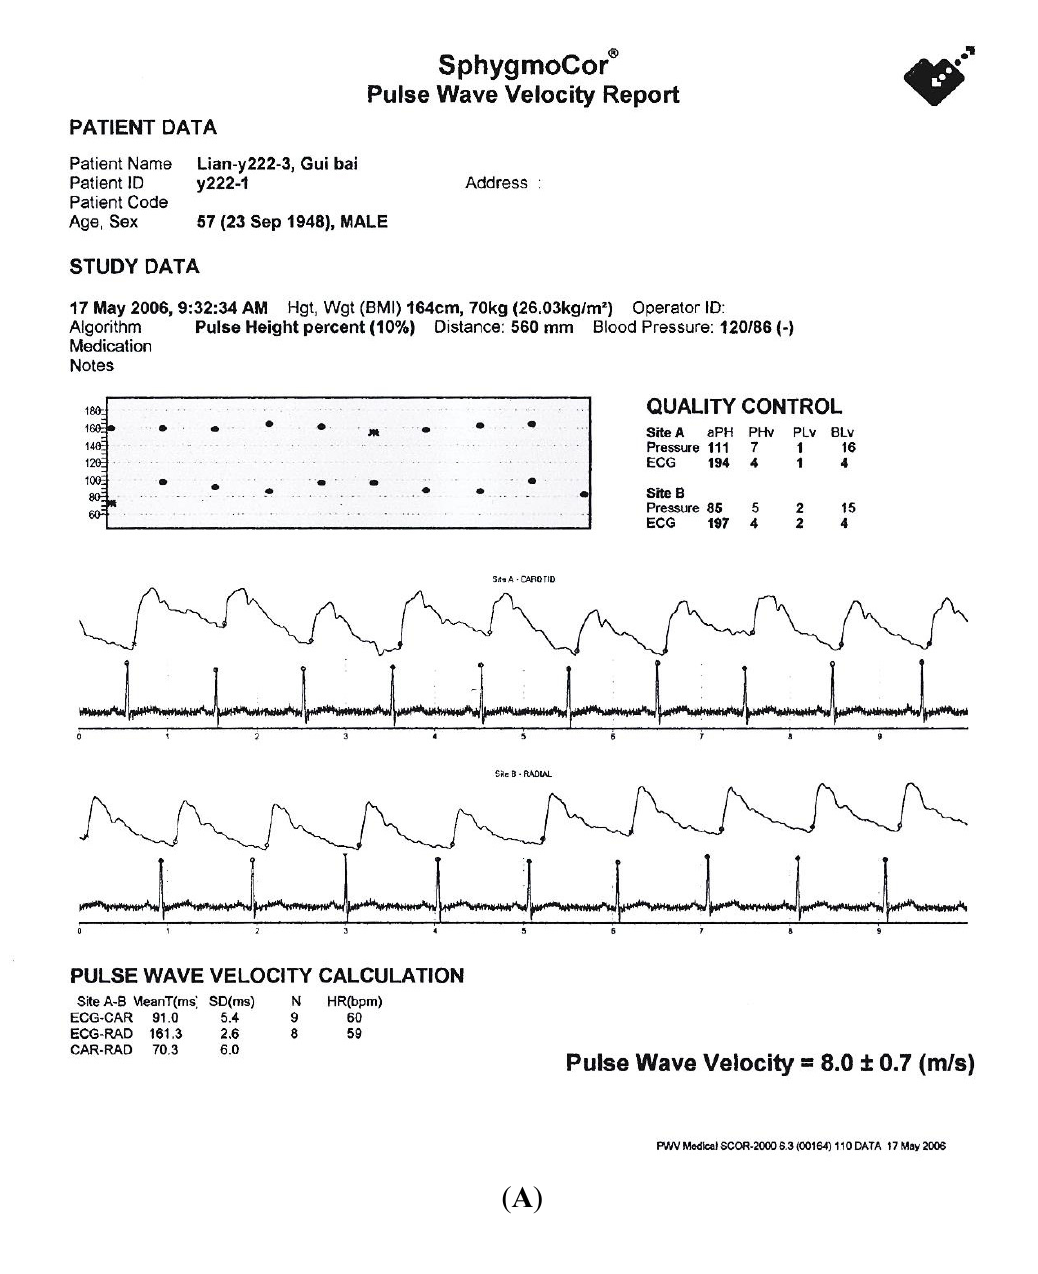
Figure 2. Measurement of pulse wave velocity ( A ) and aortic augmentation index ( B ) as marker of arterial stiffness by SphygmoCor machine (Atcor Medical, Sydney,